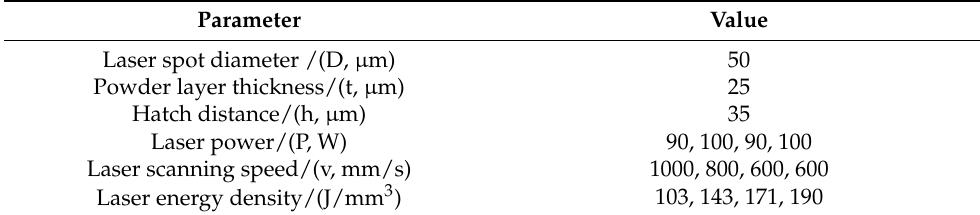
Table 2. Processing parameters set in SLM